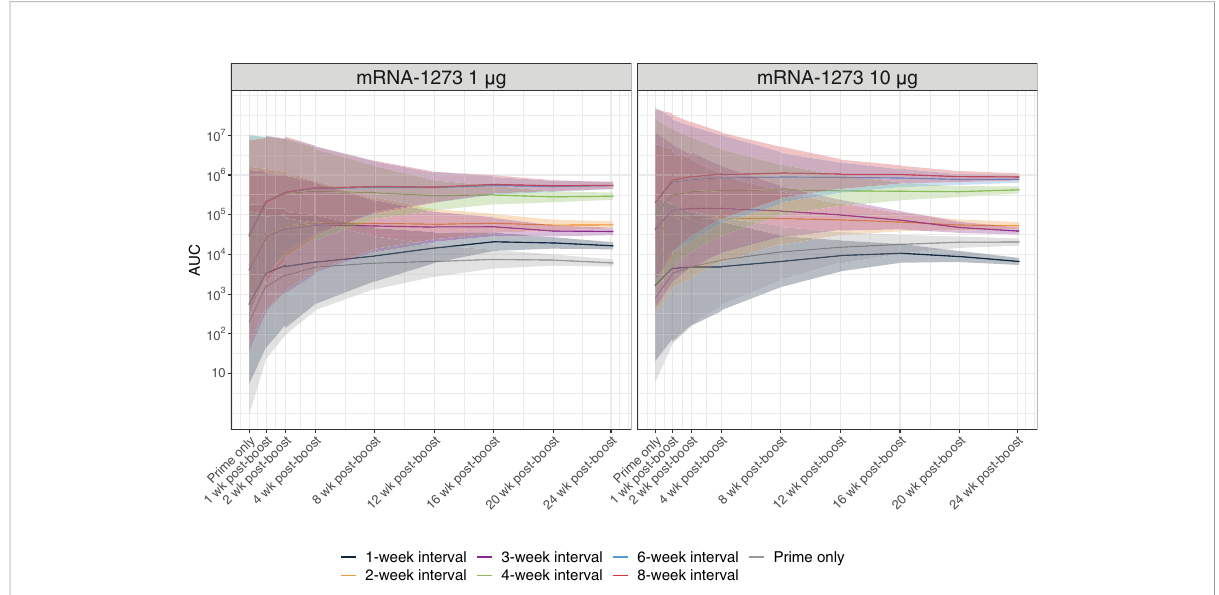
FIGURE 3 Antibody Fc-effector Function Responses. Antibody Fc-effector function was assessed using reporter cells expressing the murine Fc g RIV. Predicted serum Fc-effector responses from before dose 2 through 24 weeks after dose 2 (with corresponding 95% CIs [shaded region]; based on a Bayesian GAM with days after dose 2 as a continuous variable [see Methods for details]) are presented by dosing interval (prime only, 1-, 2-, 3-, 4-, 6-, or 8-week intervals between doses) for 1-µg or 10-µg dosing levels (n=8-10 mice per group). Results of statistical comparisons between groups based on the Bayesian GAM are presented in Table S2 and Figure S5. Observed data at individual animal level are shown in Figure S4. AUC, area under the curve; CI, con fi dence interval; GAM, generalized additive model; mRNA, messenger